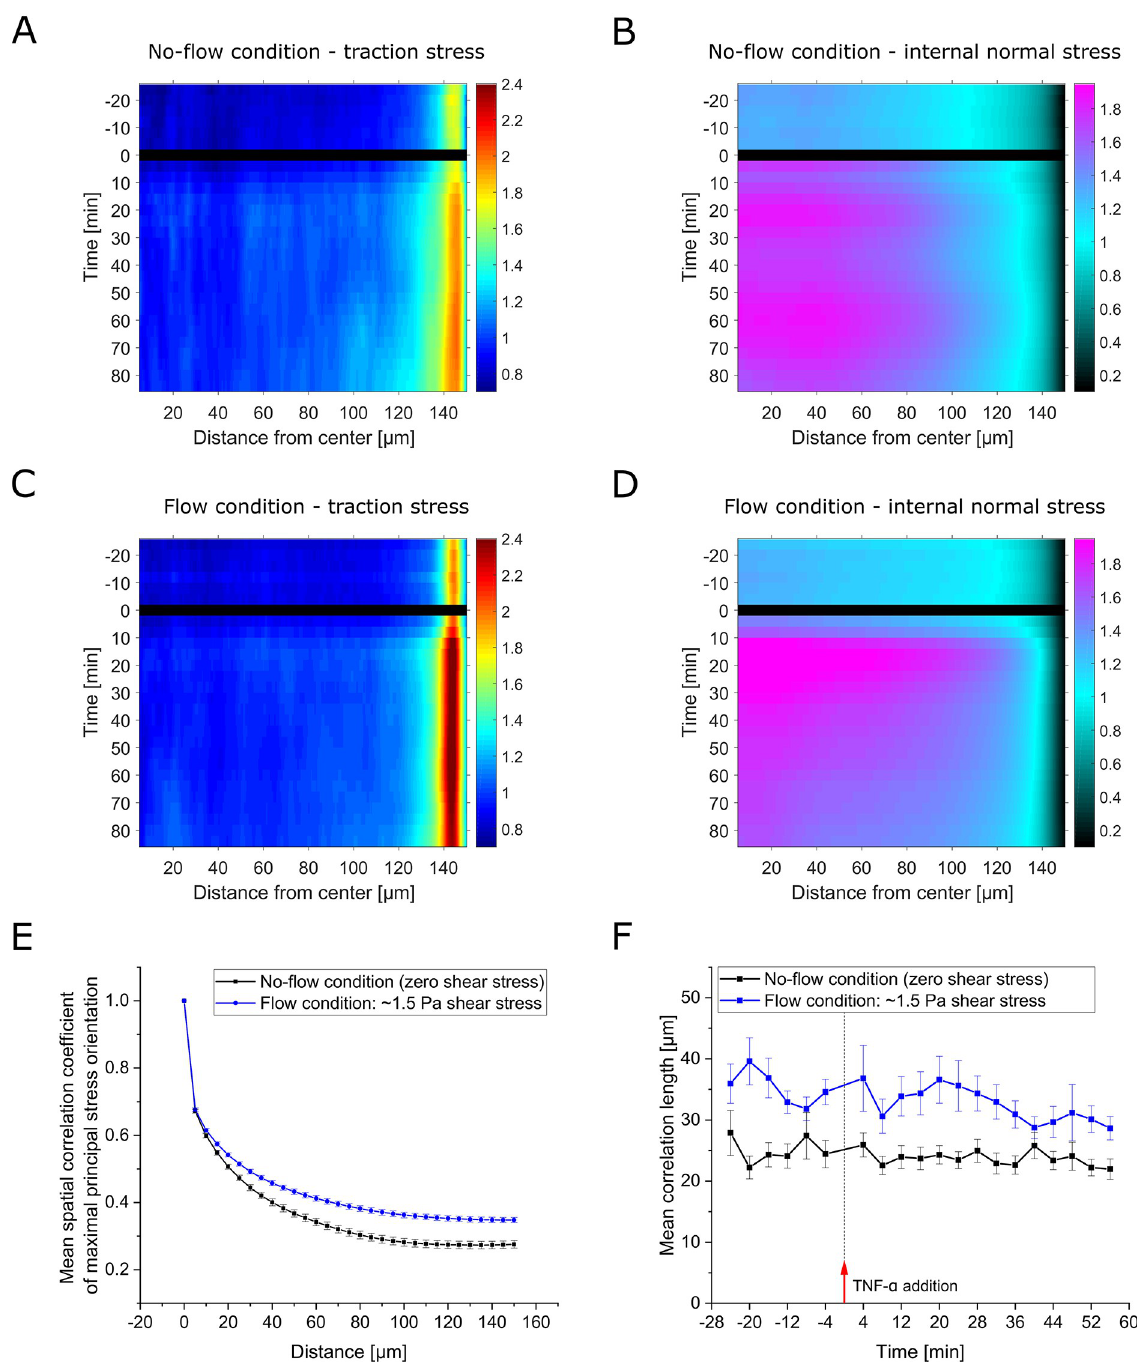
Fig 5. Spatial distribution and cooperativity of stress in response to TNF- α exposure under flow (1.5 Pa shear stress) and no-flow (zero shear stress) conditions. A-D : Kymographs showing the development of radial profiles of (A,C) substrate traction and (B,D) internal normal stress over time under (A,B) no-flow (zero shear stress) conditions and (C,D) flow (1.5 Pa shear stress) conditions. Kymographs are based on the same measurements as data in Fig 4A and 4B. Colors encode the stress intensity normalized as in Fig 4A and 4B. As application of TNF- α required some time and caused disturbance, no image data was analyzed for the respective timepoint 0 (black line). The overall increase in stress intensity fits the time course of the average values shown in Fig 4A and 4B. While the rapid increase in traction stress is largely generated at the edge of the monolayer, a delayed increase of traction stress in the inner region can still be observed (see A,C). Interestingly, the discrepancy between edge and inner region of the monolayer for the exerted traction stress is significantly higher in the presence of flow (see also S2 Fig). The initial rise inflicted by the administration process is apparent throughout the inner region of the monolayer (see B). In